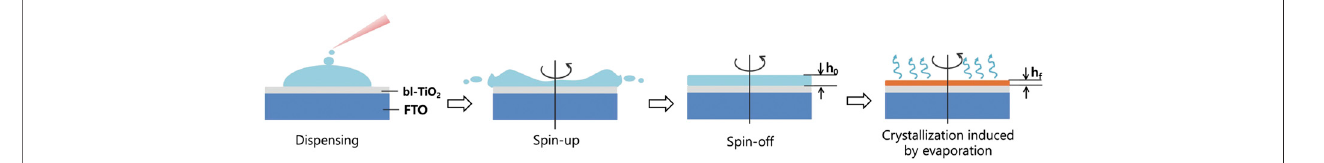
FIGURE 1 | Illustrations of the dynamic evaporation of solvent in the spin-coating process. Reprinted with permission from Heo et al. (2014). Copyright 2014 WILEY-VCH Verlag GmbH & Co. KGaA,